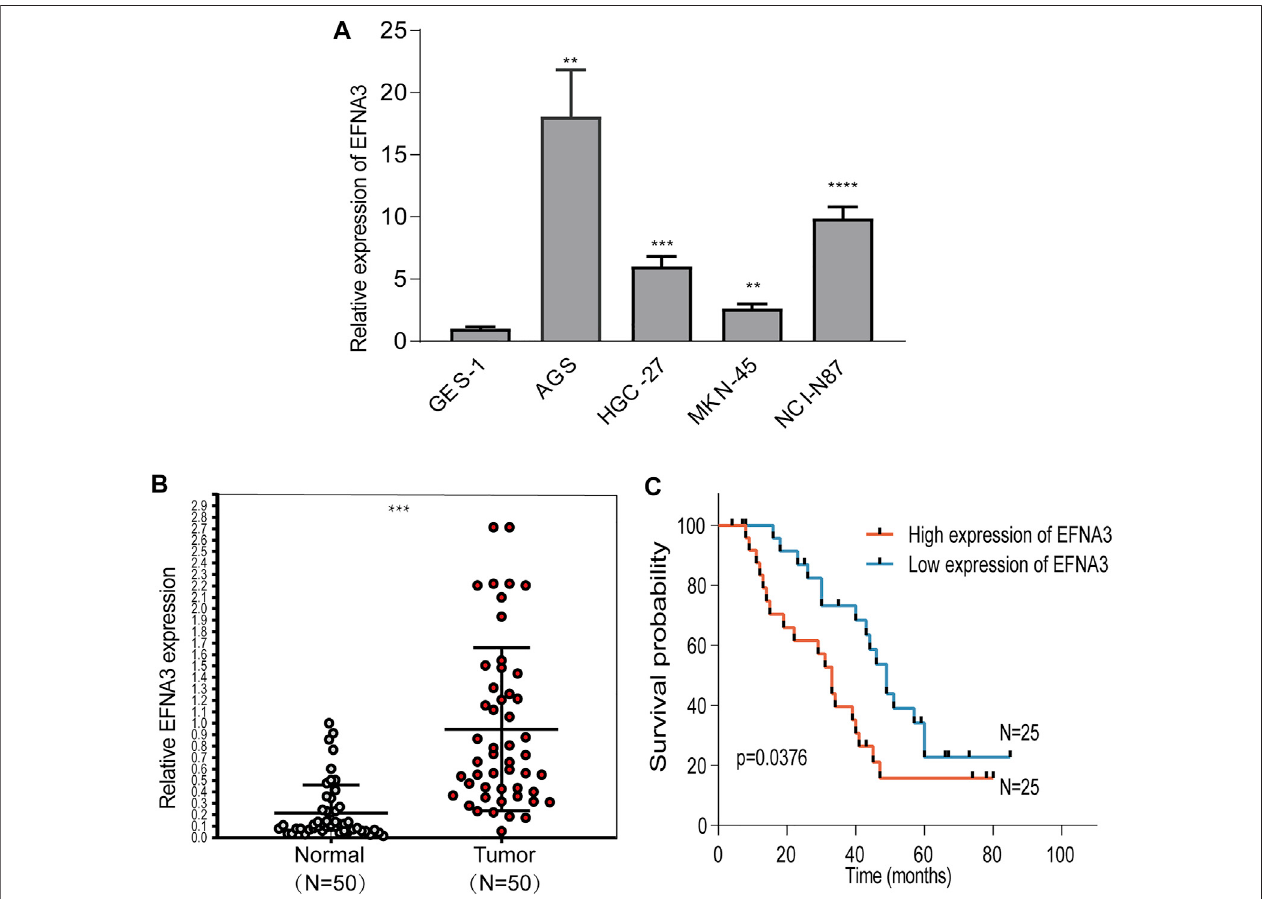
FIGURE 6 | EFNA3 expression was signi fi cantly up-regulated in cell lines and GC tissues. qRT-PCR showed that EFNA3 expression was up-regulated in GC cell lines (A) and GC tissues (B) . High EFNA3 expression was related to shorter OS time (C) . (** P < 0.01, *** P < 0.001, **** P < 0.0001).